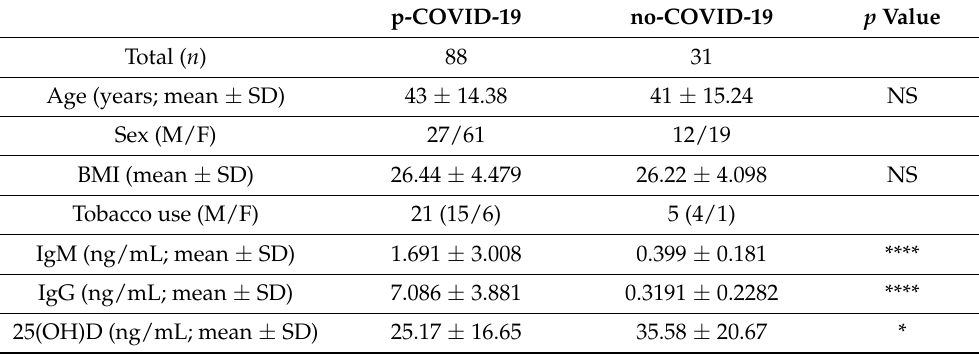
Table 1. The characteristics of the study